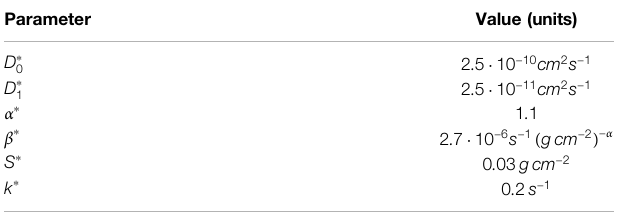
TABLE 1 | Reference parameters (denoted by *) as obtained by the best fi t in the present case study. Parameter